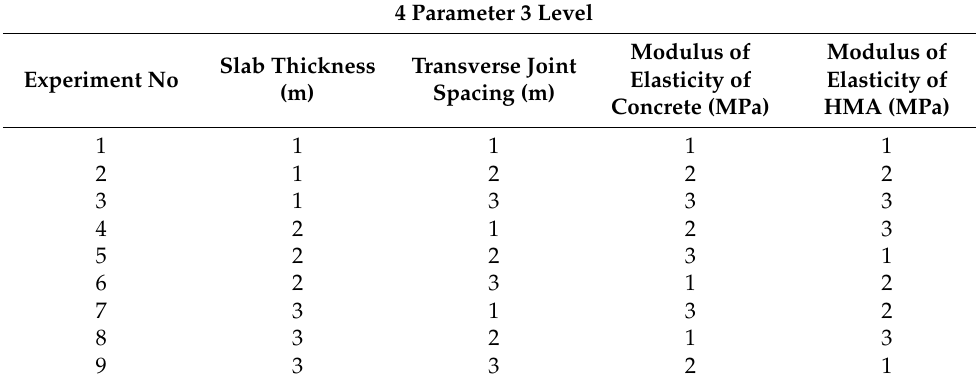
Table 6. L9 orthogonal array.